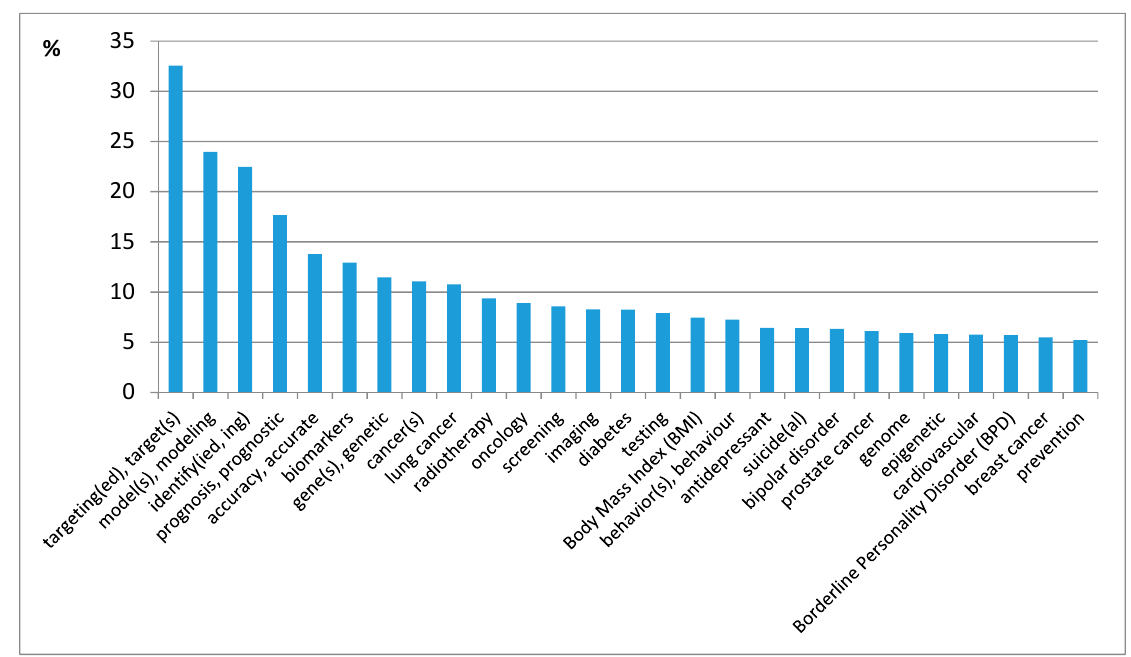
Figure 10. Ranking of terms that appeared before 2007 by relative growth over the last years (N is the relative growth).